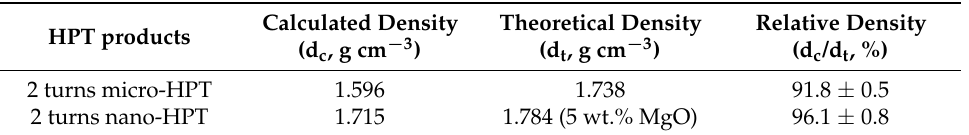
Table 2. Relative density of the HPT products consolidated from the atomized Mg and condensed Mg powder